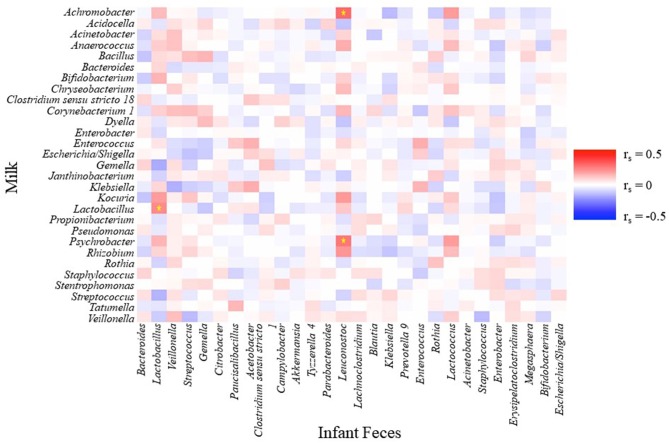
Spearman rank correlations between an aggregation of the 10 most-abundant bacterial genera in infant feces and an aggregation of the 10 most-abundant bacterial genera in milk. Stars indicate P < 0.01 and rs < −0.3 or rs > 0.3.